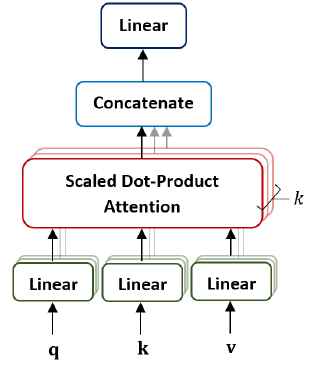
Figure 5. The architecture of the multi-head self-attention